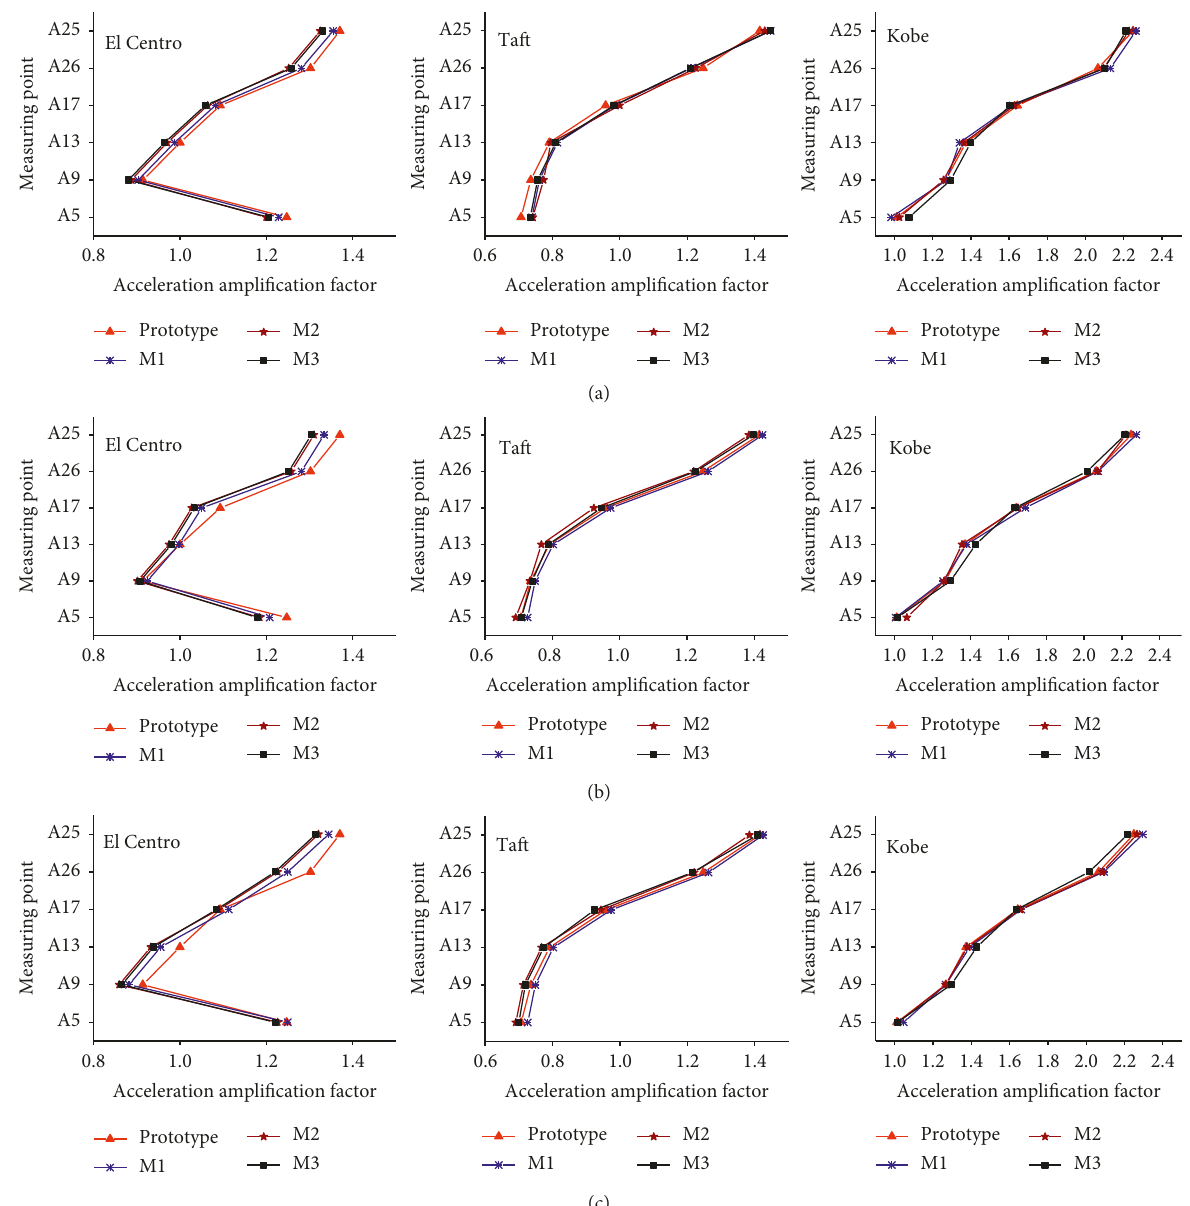
Figure 9: Acceleration amplification factor under the different seismic wave tests at different monitoring points. (a) 0.1g. (b) 0.2 g. (c)